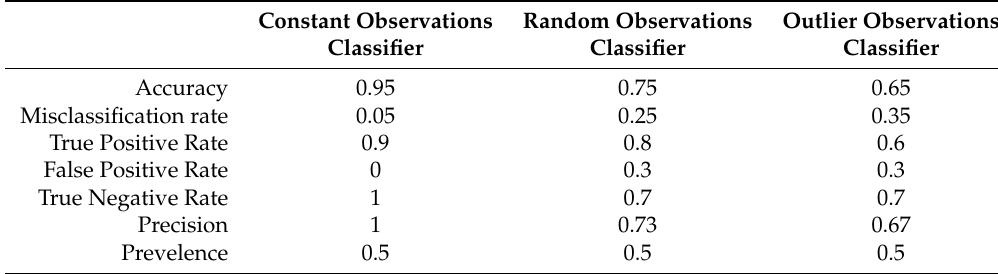
Table 2. Prediction rates of the